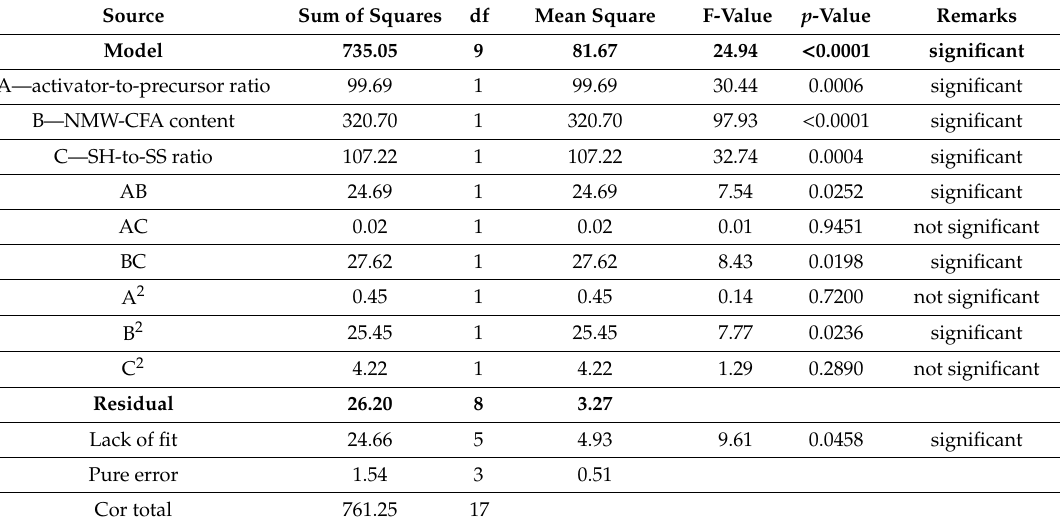
Table 7. ANOVA for the quadratic model.ANOVA for the quadratic model.